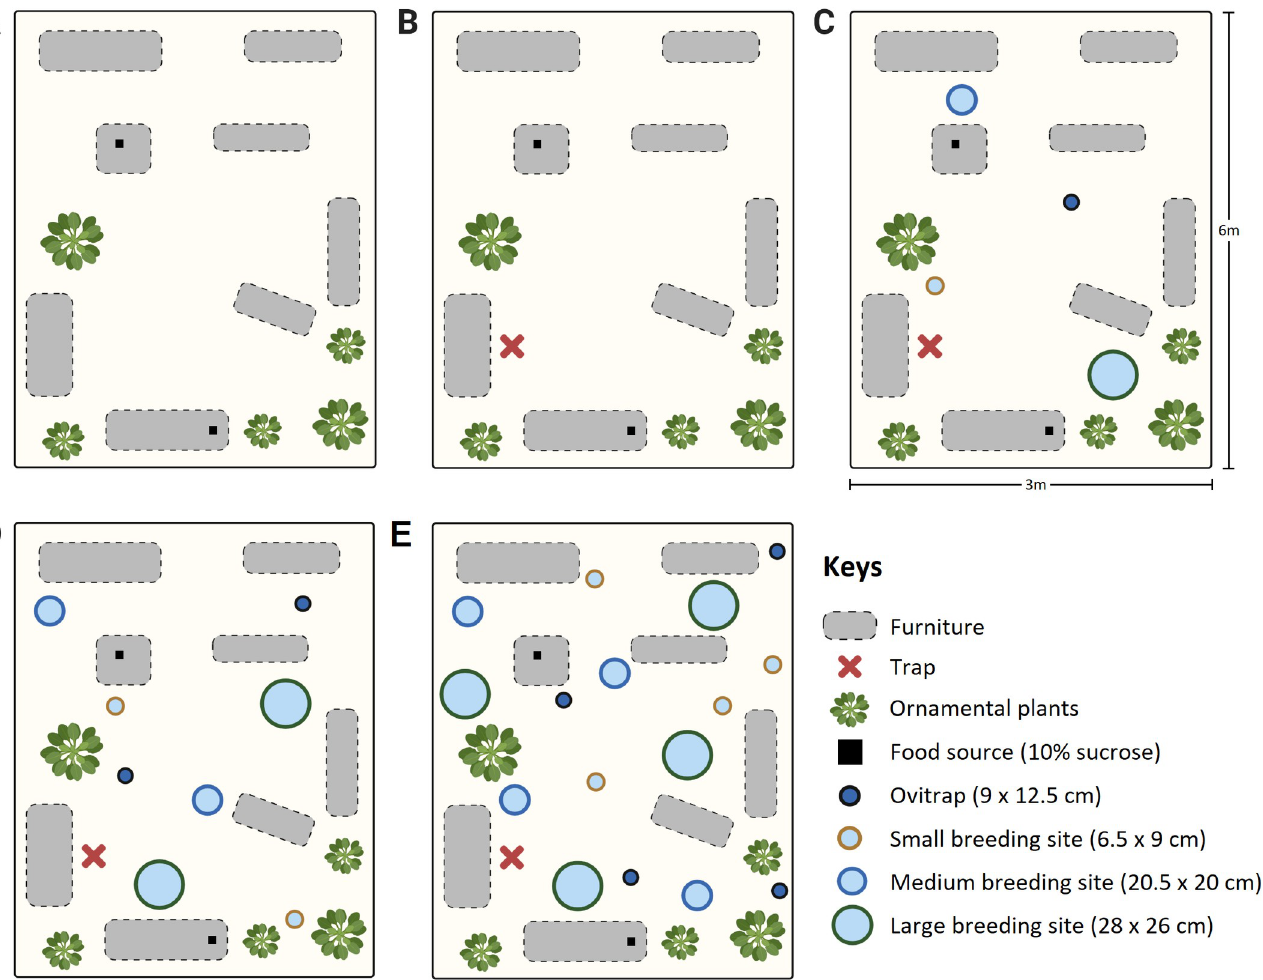
Fig 1. Illustration of the experimental setup showing the distribution of breeding sites and trap position in the simulated outdoor environment. Settings (A) without trap, with (B) 0, (C) 4, (D) 8 or (E) 16 containers of different sizes. Figure created using BioRender (https://biorender.com).